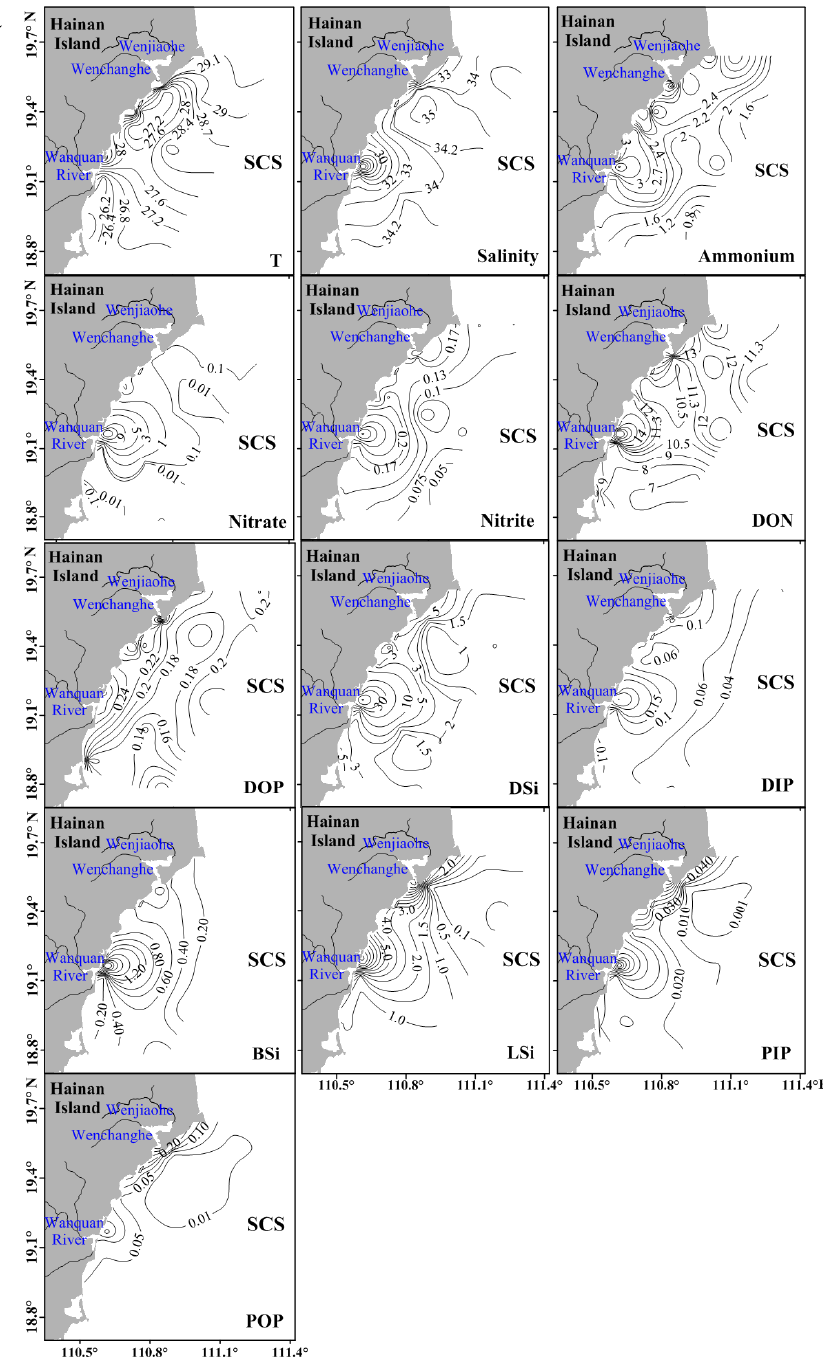
Fig. 3. Horizontal distributions of surface temperature ( ◦ C), salinity, and nutrients (µM) along the eastern coast of Hainan Island. (a) 18– 22 August 2007; (b) 27 July–2 August 2008; (c) 6–12 April 2009; (d) 29 August–1 September 2008; (e) 29 July–3 August 2009.